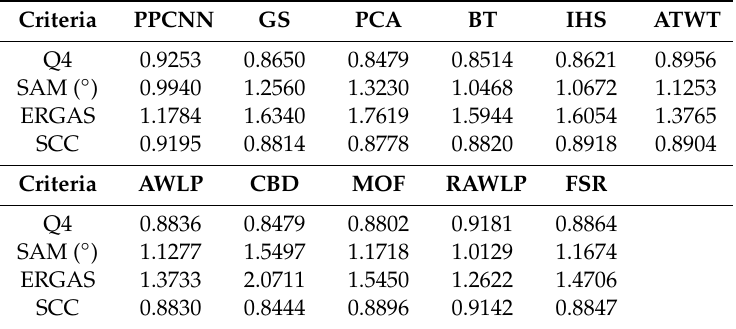
Table 6. Comparison results for Xinjiang